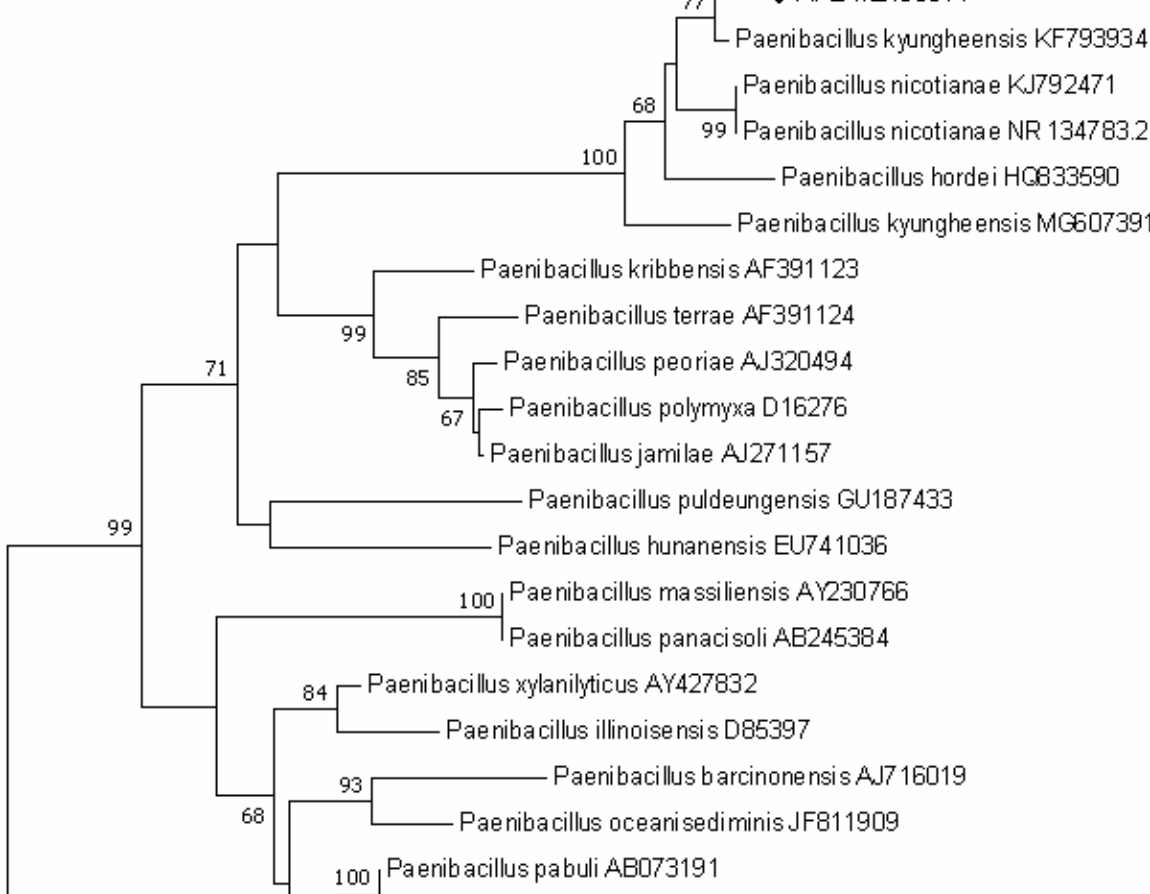
Figure 2. Neighbor ‐ joining tree based on 16S rRNA gene sequence analysis showing the phylogenetic relationships of strain AFl2 and members of the genus Paenibacillus . Bootstrap values higher than 60% based on 1000 replications are shown at branching points. Thermobacillus xylanilyticus and Cohnella hongkongensis were used as an outgroup. Scale bar, 0.01 sub ‐ stitutions per nucleotide position. Based on the morphological and biochemical characteristics as well as the data of 16S rRNA genes, we identified AFI1 as Bacillus megaterium AFI1 ( B. megaterium AFI1) and AFI2 as Paenibacillus nicotianae AFI2 ( P. nicotianae AFI2) .